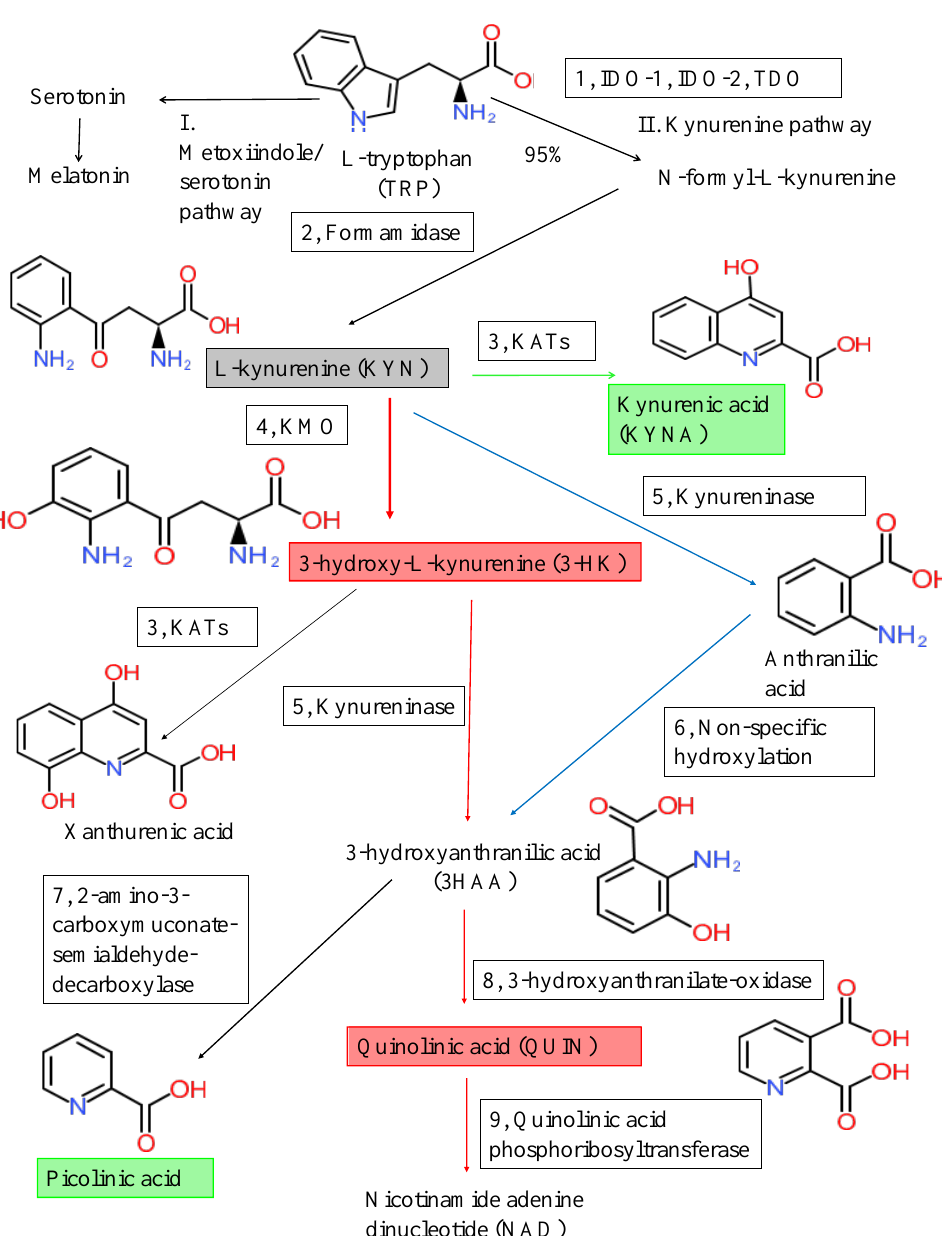
Figure 1. Tryptophan metabolism and the kynurenine pathway. The kynurenine pathway (KP) is the main degradation route of tryptophan (TRP) metabolism producing the end-product nicotinamide adenine dinucleotide (NAD). The indoleamine-2,3-dioxygenase-1 and 2 (IDO-1 and IDO-2), and the tryptophan 2,3-dioxygenase (TDO) (1) are the first rate-liming enzymes that convert the l -TRP to N -formyl- l -kynurenine. N -formyl- l -kynurenine is converted by formamidase (2) to l -kynurenine ( l -KYN) (gray box). l -KYN is metabolized into various bioactive compounds: the neuroprotective metabolites are kynurenic acid and picolinic acid (green boxes), while the neurotoxic ones are 3-hydroxy- l -kynurenine (3-HK) and quinolinic acid (red boxes). The main enzymes of the KP are following: 1: tryptophan 2,3-dioxygenase (TDO) and indoleamine 2,3-dioxygenase 1 and 2 (IDO-1 and IDO-2), 2: formamidase, 3: kynurenine aminotransferases (KATs), 4: kynurenine-3-monooxygenase